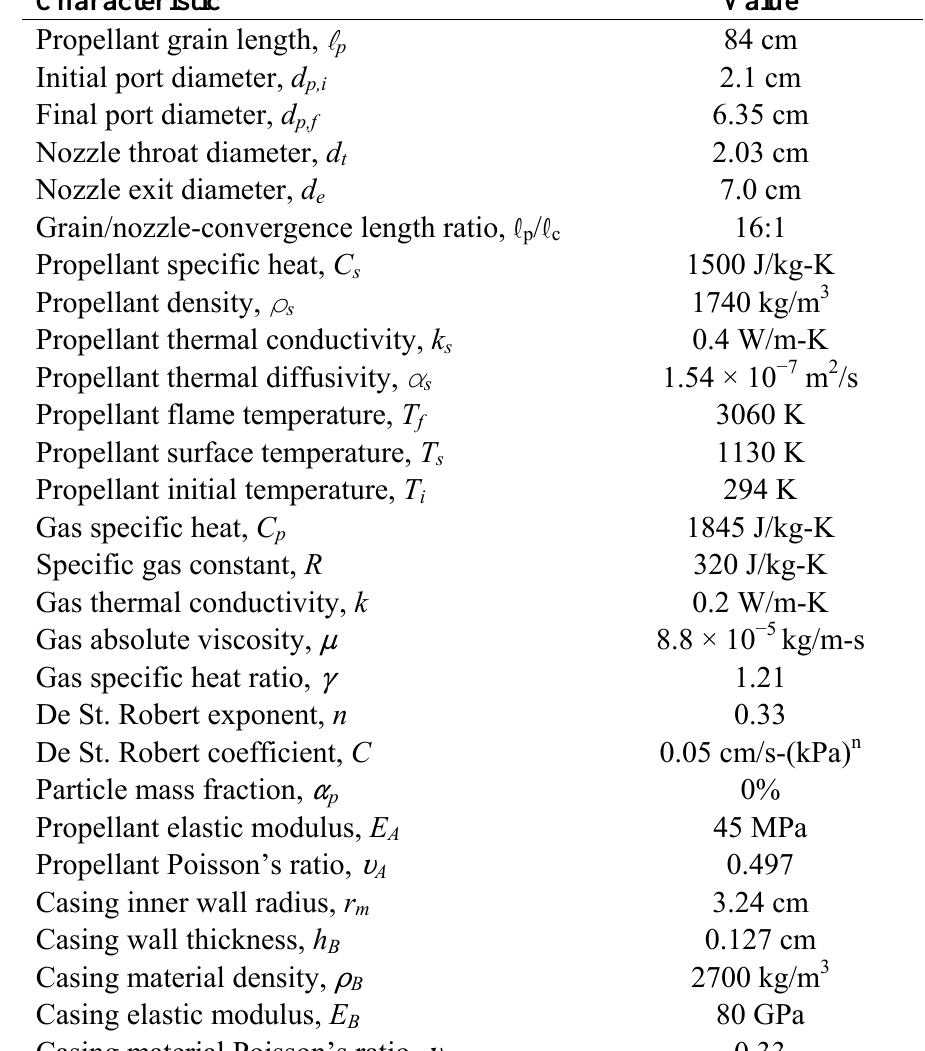
Table 1. Reference motor